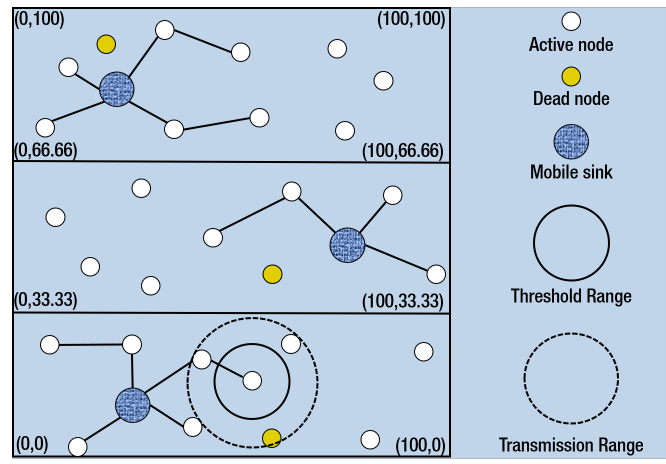
Figure 12. Data transmission in Regional Sink Mobility (RSM)